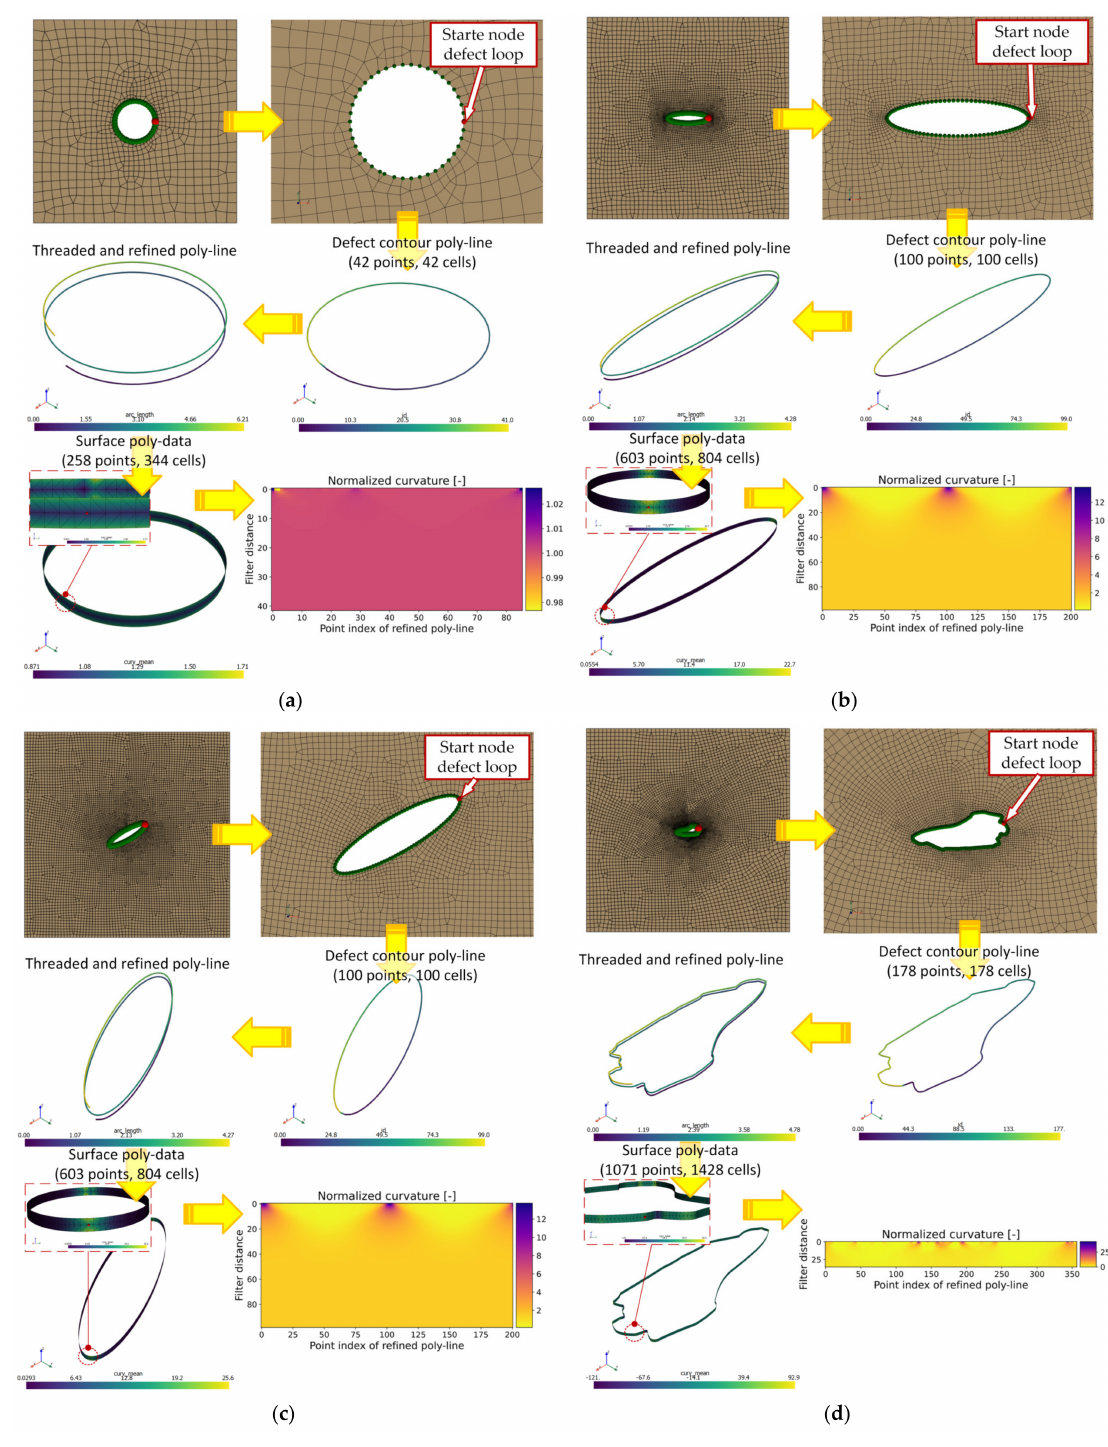
Figure 7. Curvature workflow exemplified for different defect geometries: ( a ) Circular hole-in-plate (mesh ‘circle_lin_R1mm_v1’); ( b ) Elliptical hole-in-plate (mesh ‘ellipsis_lin_rot0deg_v1’); ( c ) In- clined elliptical hole-in-plate (mesh ‘ellipsis_lin_rot30deg_v1’); and ( d ) Elongated defect (mesh